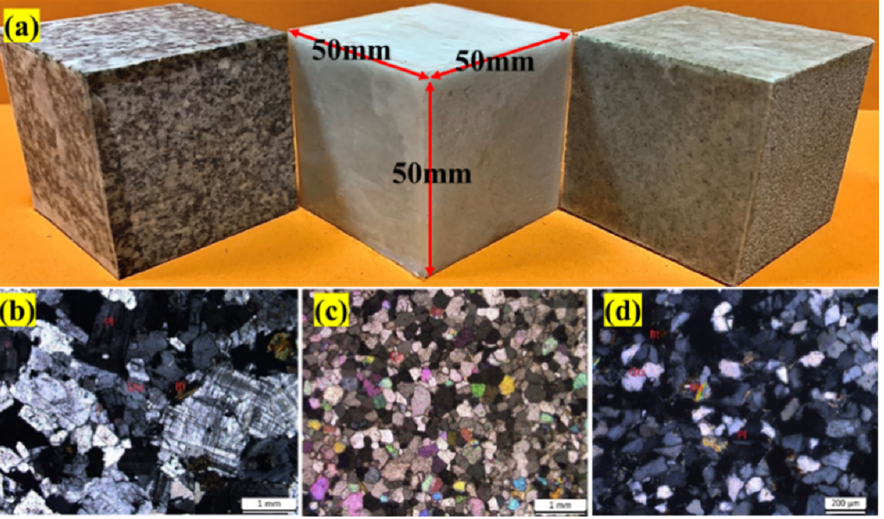
Figure 2. Rock specimens used in this study: ( a ) specimen size, and ( b – d ) mineral components of granite, marble, and sandstone, respectively.